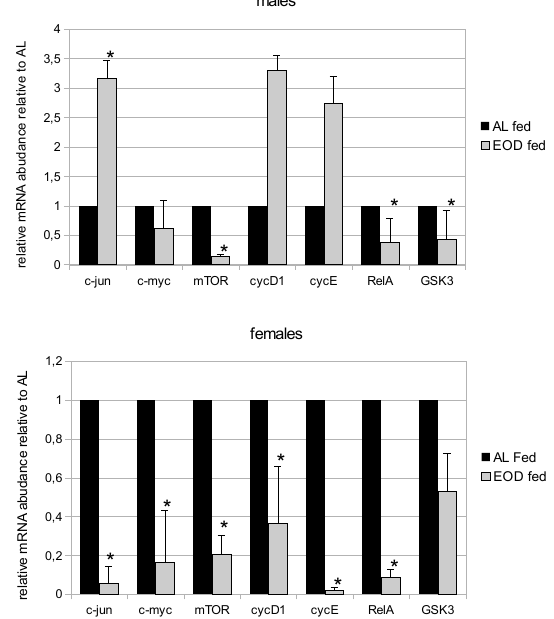
Figure 2. Expression of mRNA for chosen protooncogenes in male and female mice on EOD diet and AL fed. Data expressed as relative mRNA abundance—fold change relative to AL animals as 1. Significantly different from AL group * p < 0.01.